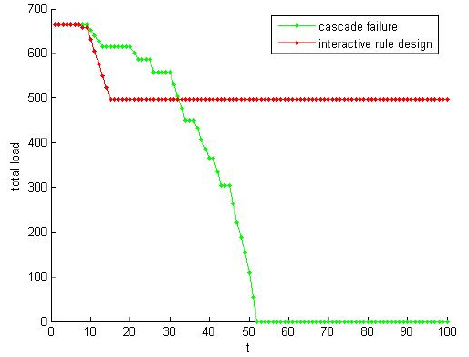
Figure 19. The effect of the interactive rule design. Figure 19. The e ff ect of the interactive rule